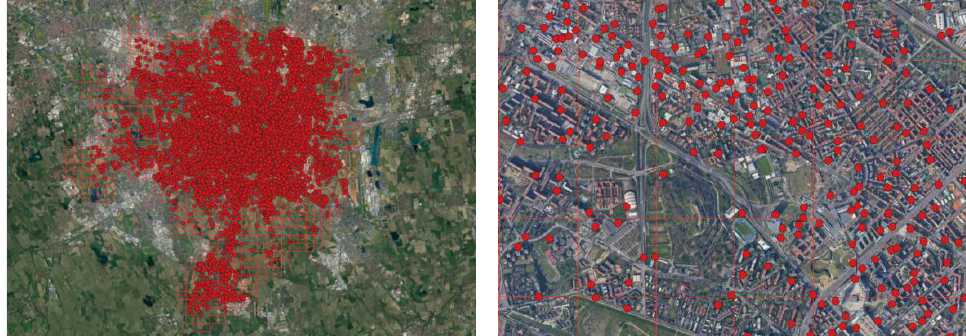
Figure 8. Left picture: location of the SSs overlapped on the considered grid layer; right picture: zoom of the point layer containing the SSs and the polygon layer of the grid.